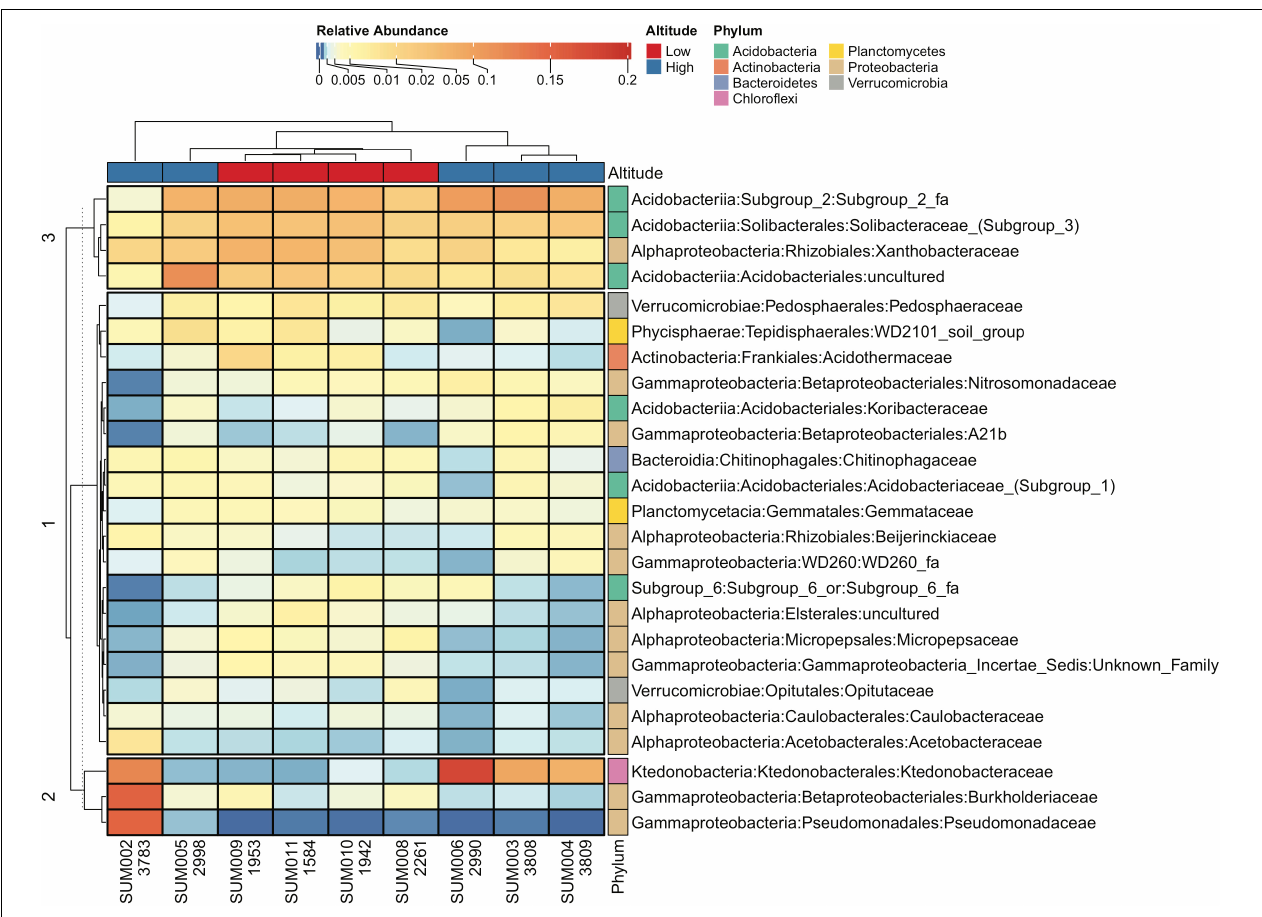
FIGURE 6 | Heatmap of the bacterial soil community in soil samples for the 25 most abundant families. Samples have been classified as low (red) or high (blue) according to altitude. Except for sample SUM005, there is a sharp differentiation in community structure between high and low altitude samples. Values for altitude are included below each sample